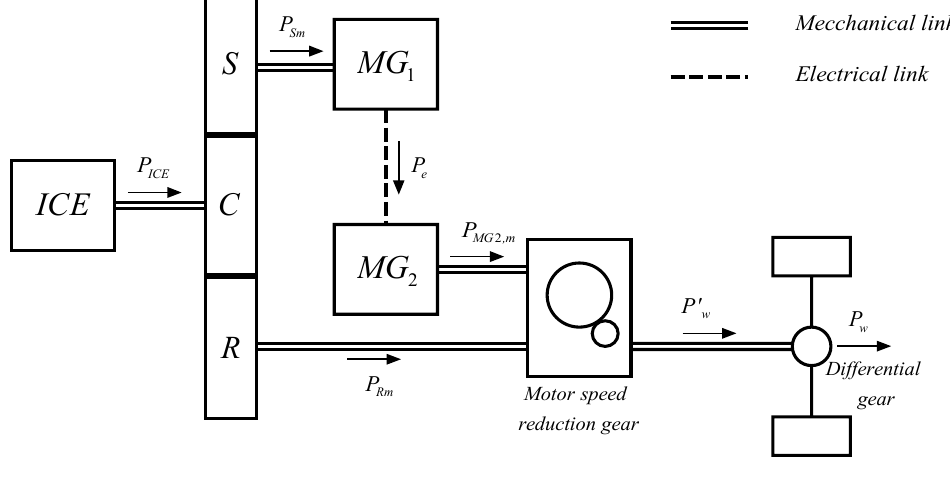
Figure 3. CVT energy convention.